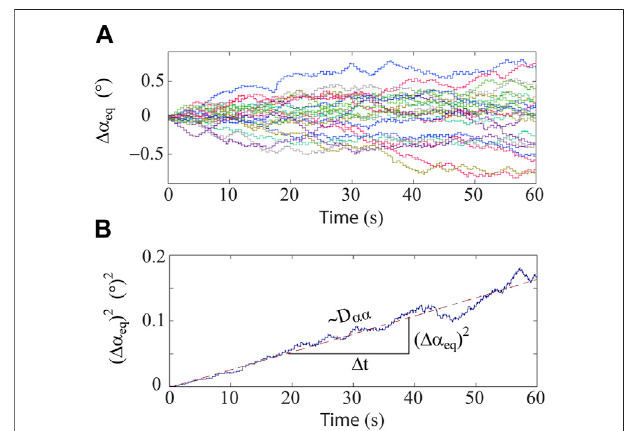
FIGURE 4 | A long-run simulation of 24 electrons experiencing cumulative linear scattering interactions, resulting in quasilinear diffusive behavior. (A) Change in equatorial pitch angle of all particles as a function of time. (B) The variance of all particles equatorial pitch angles increases linearly as a function of time, consistent with diffusive scattering. The rate of change of the variance yields the pitch angle diffusion coef fi cient, D αα . Adapted from Bortnik et al.